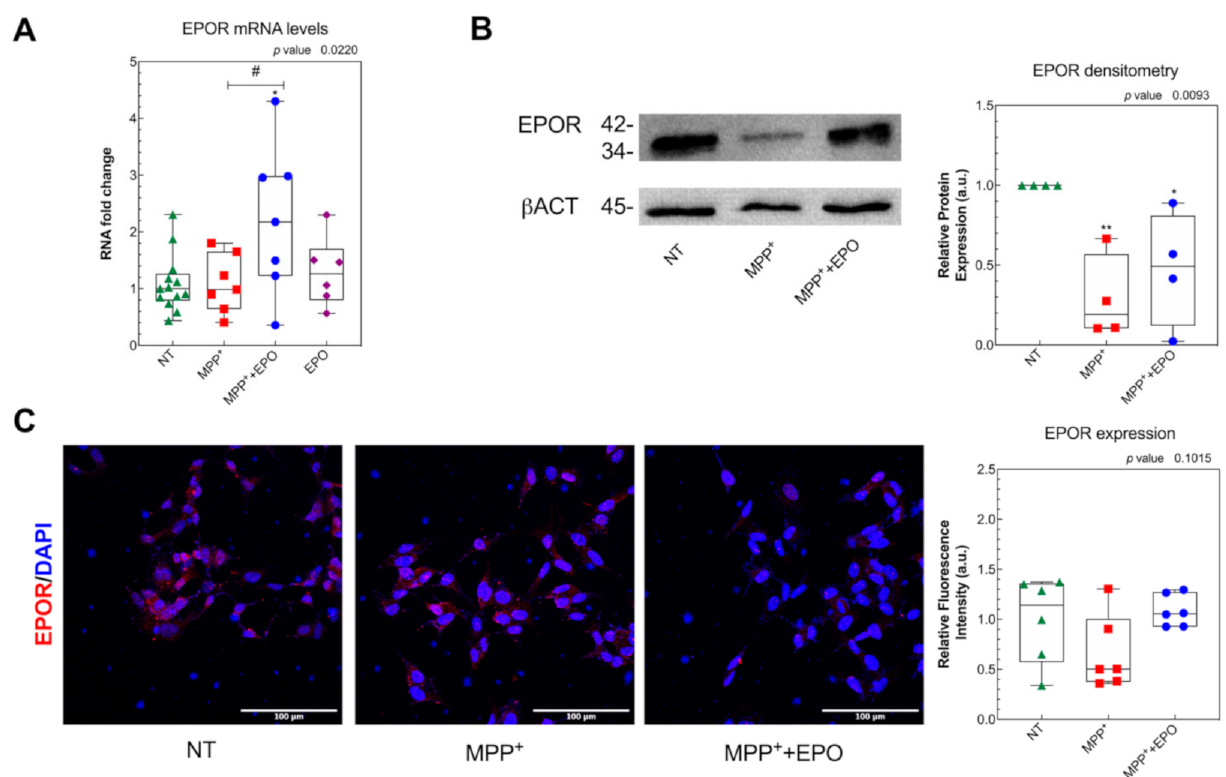
Figure 3. Effect of EPO on the induction of EPO receptor (EPOR) expression. ( A ) The expression levels of EPOR mRNA were evaluated by Real Time-PCR in SH-SY5Y cells, after 24 h of treatment with MPP + , MPP + +EPO or EPO. GAPDH was used as housekeeping gene. Data are expressed as mean ± SEM of 3 replicate values in 3 independent experiments ( n = 9) and results are represented as percent of NT. * p < 0.05 vs. NT, # p < 0.05 vs. MPP + . ( B ) EPOR protein expression was evaluated by Western blot in SH-SY5Y cells, after 24 h of treatment with MPP + or MPP + +EPO. GAPDH was used as loading control. The intensity of the band and relative protein expression was evaluated with the software Image-J (NIH). Data reported refer to the mean ± SEM of 4 independent experiments ( n = 4) and they are represented as intensity of EPOR versus beta-actin, in relation to NT. * p < 0.05; ** p < 0.01 vs. NT. ( C ) EPOR protein expression was evaluated by immunofluorescence analysis in SH-SY5Y cells, after 24 h of treatment with MPP + or MPP + +EPO. Fluorescence quantification and the relative protein expression were performed with the software Image-J (NIH). Scale bar: 100 µ m. Data reported are mean ± SEM (3 fields per experiment, 2 independent experiments; n = 6) and results are represented as percent of NT. The grey area delimits the value (mean ± SEM) obtained in